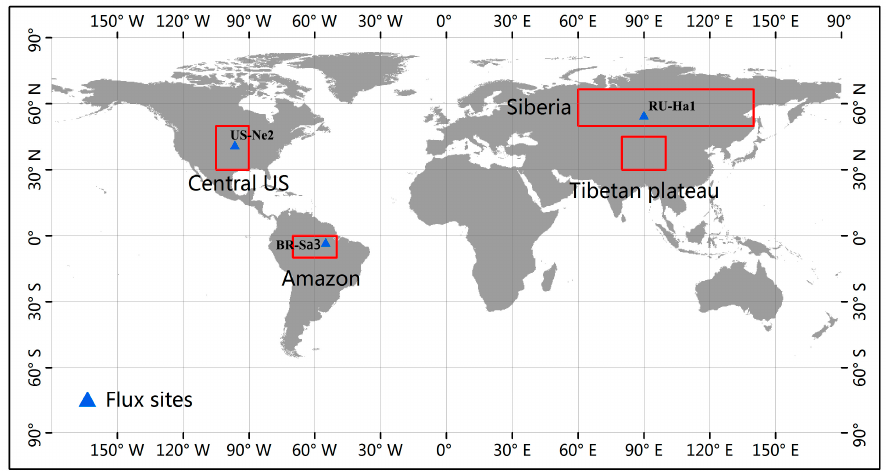
Figure 1. Locations of the four focus regions (Amazon, Central US, Siberia and Tibetan Plateau) and three flux sites (BR-Sa3, RU-Ha1 and US-Ne2).